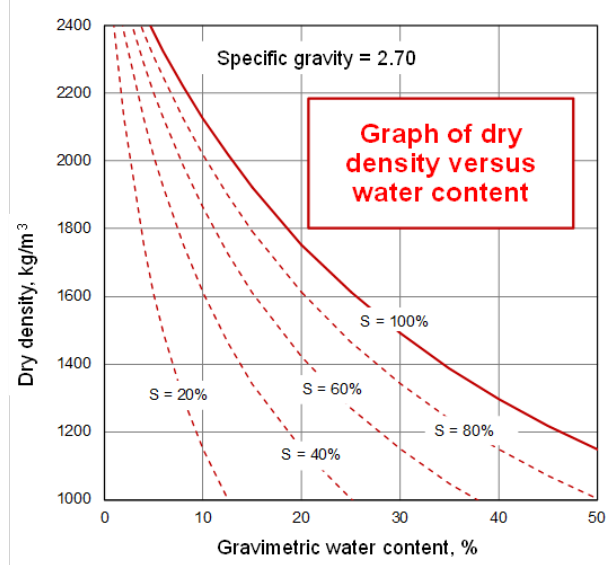
Figure 3. Illustration of possible volume and mass related variables for an unsaturated soil.